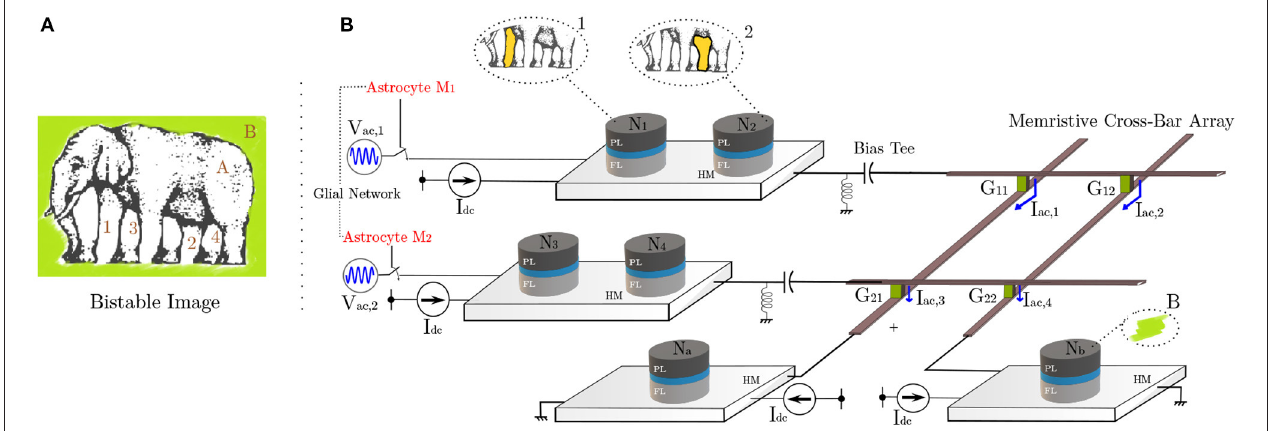
FIGURE 5 | (A) The optical illusion induces confusion in the viewer concerning association among different apparent limbs with the body and the background ( Courtesy of Roger Shepard’s “L’egsistential paradox" ) (Shepard, 1990). (B) MTJ system architecture depicting hierarchical organization of neurons. The illustrated binding problem is mapped to this hardware with one possible interpretation shown. The connection between different neuron layers is implemented by the memristive cross-bar array with initially untuned synaptic weights. Unsupervised STDP learning rule causes the weights to evolve, making the network to finally elicit synchronous responses